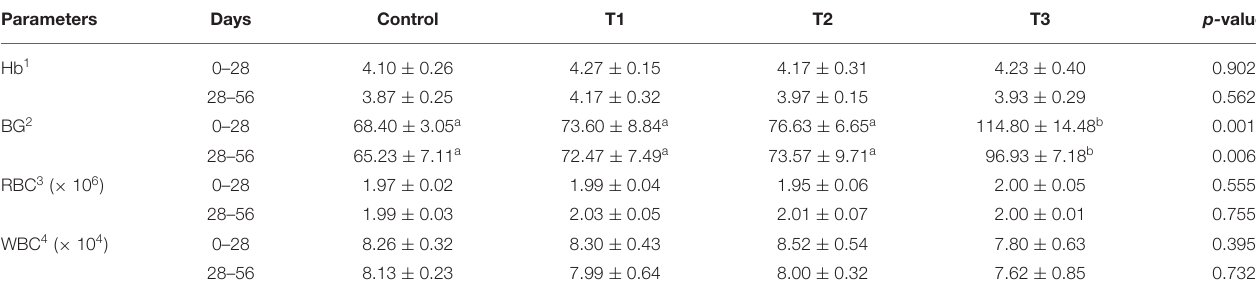
TABLE 3 | Hematological parameters of tilapia, O. niloticus, fed with control and experimental diets after 28 or 56 days of feeding trial. Parameters